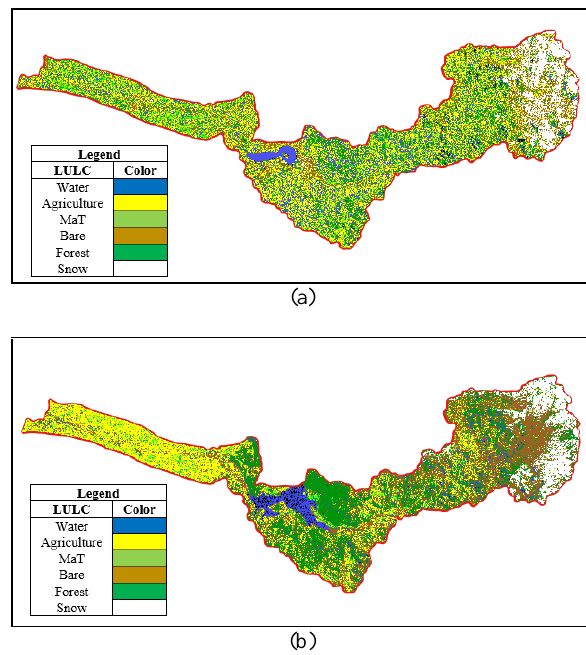
Figure 3. Results of supervised classification SAM for (a) 1999 and (b) 2019.